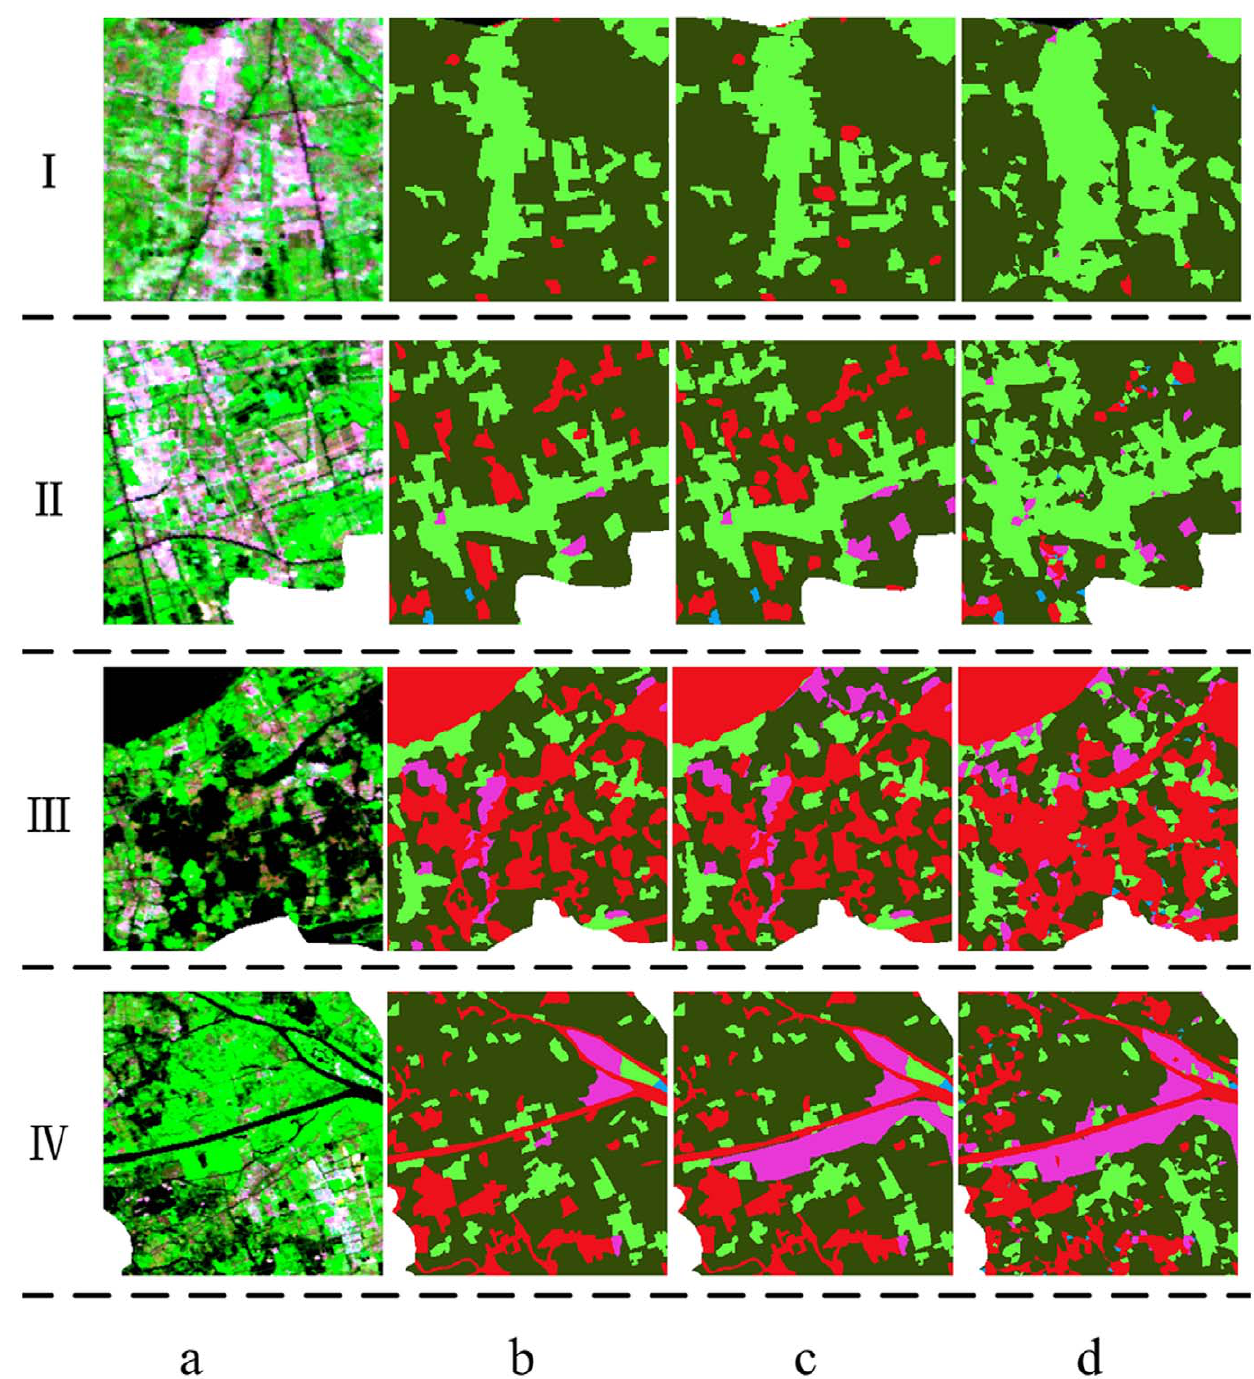
Figure 6. Comparison between the land cover types in the yellow rectangle in Fig. 5. (a) HJ-1 image of 2009.9.22;(b)land cover of 2005;(c)land cover of 2009;(d)land cover classified by the new